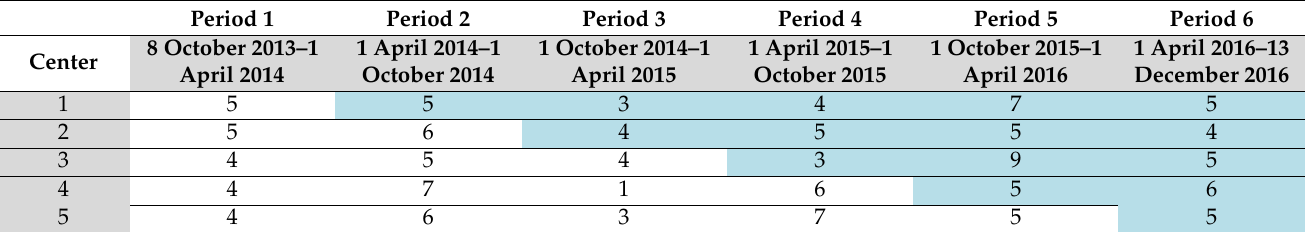
Table 1. Number of patients included in each center and each period. The shaded boxes correspond to time periods in intervention.